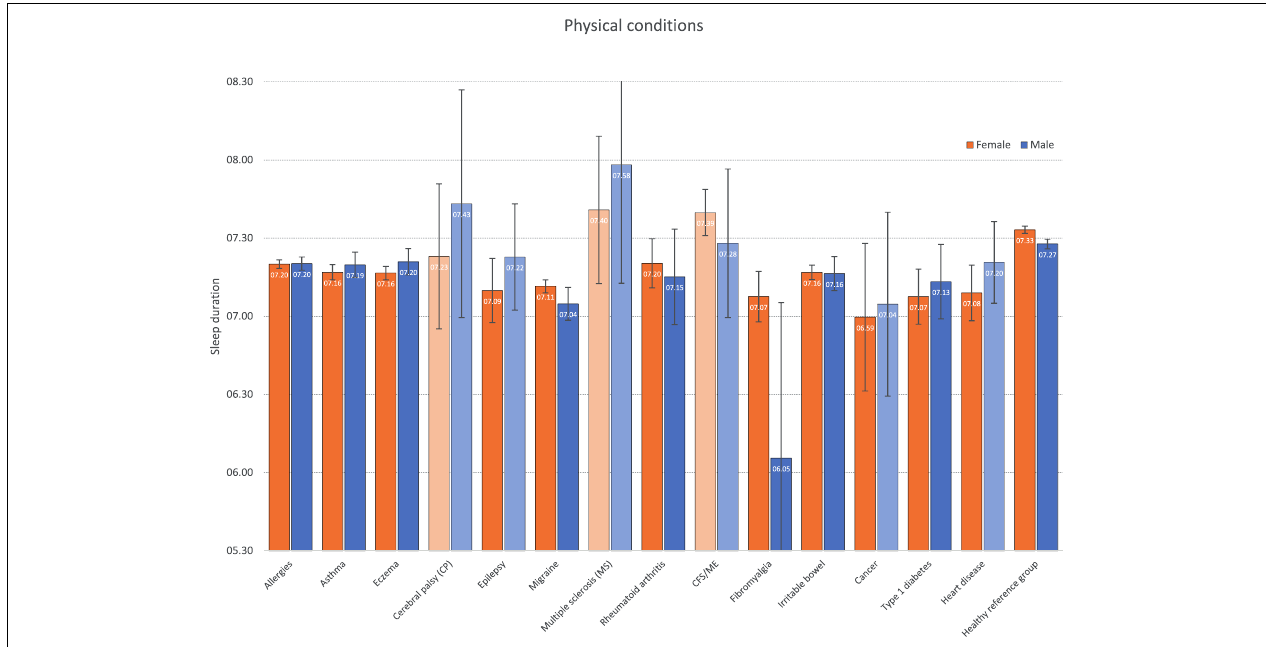
FIGURE 2 | Weekday sleep duration across physical conditions by gender. Bars represent age-adjusted Estimated Marginal Means (EMM), and error bars represent 95% confidence intervals. Light-colored bars represent non-significant differences ( P > 0.05) compared to the healthy reference group within each